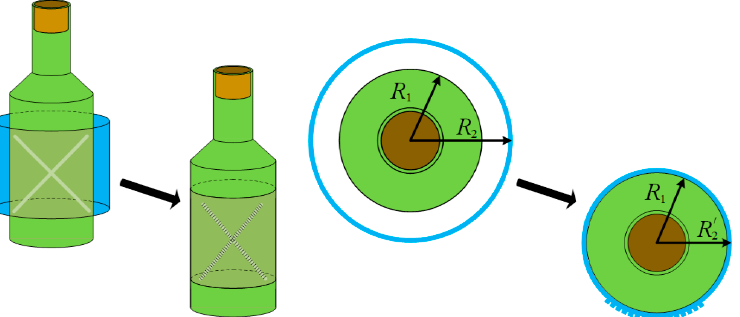
Figure 4. The manifestation of relief after heat shrinkage of a film with hidden markings on a cylindrical container. R 1 , R 2 , R 2 ′ are dimensions of containers and shells on containers before and after heat shrinkage.